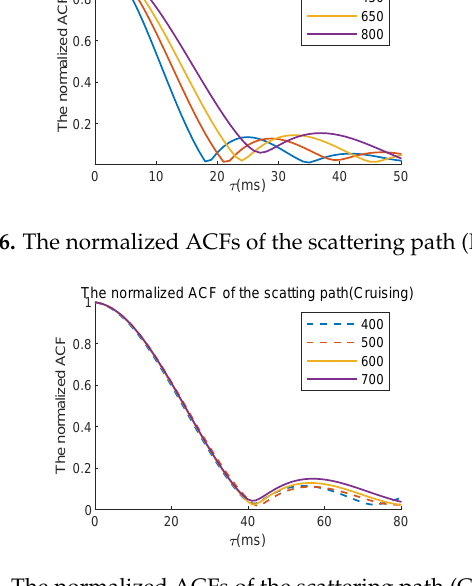
Figure 7. The normalized ACFs of the scattering path